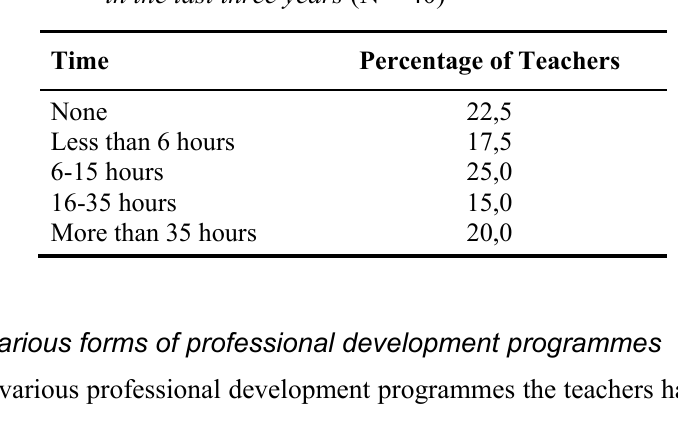
Table 5 : Duration of professional development